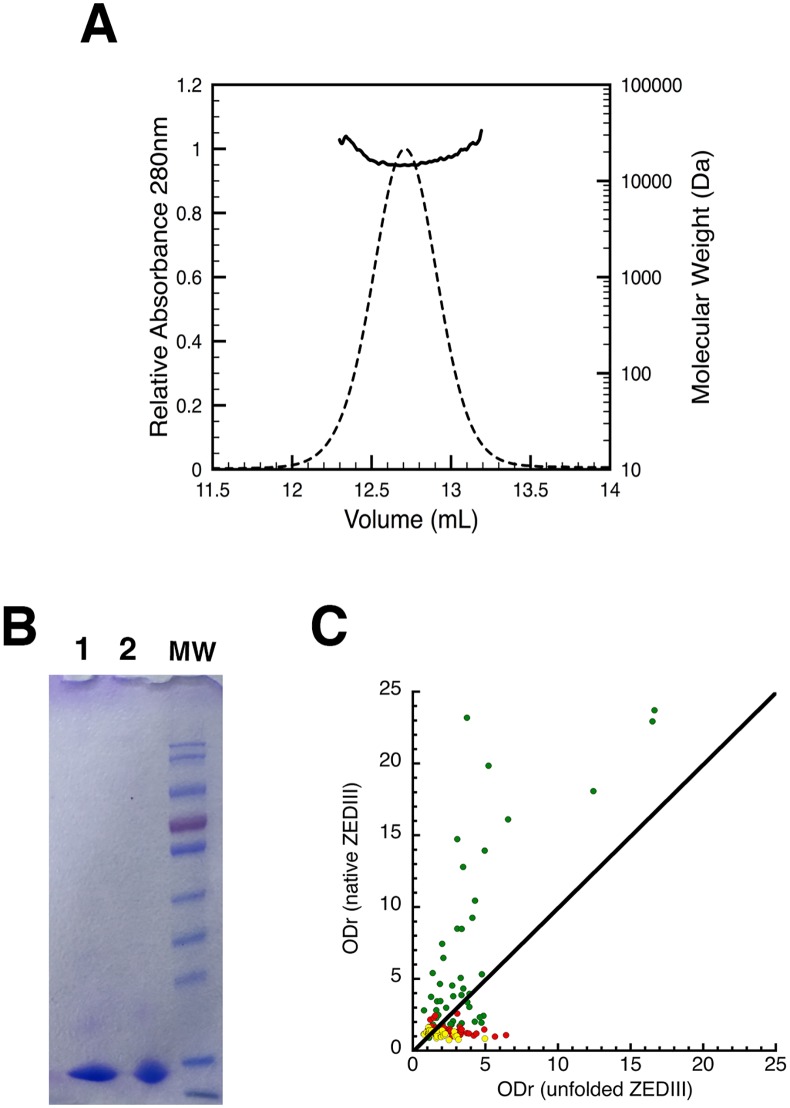
Characterization of refolded ZEDIII.(A) Raw data of the analytical size-exclusion chromatography of ZEDIII followed by MALS/UV/refractometry. The abscissa and ordinate axes correspond to the elution volume and the molecular weight (Da) obtained by MALS, respectively. The OD280nm is represented by the non-continuous black trace and the molecular weight by the continuous black trace. The value of the measured molar mass (14.5 kDa) at the volume corresponding to the top of the peak is reported. The population of ZEDIII with a molar mass of 14.5 kDa is more than 95%. (B) Purity of ZEDIII after refolding and purification analyzed on an SDS-PAGE gel stained with Coomassie blue. MW: molecular weight (in kDa). Lane 1: ZEDIII under reducing conditions (DTT); Lane 2: ZEDIII under non-reducing conditions. (C) Recognition of linear and conformational epitopes by ZIKV-IgM-positive (green, n = 50), flavivirus (red, n = 50), and negative (yellow, n = 50) groups by ELISA.